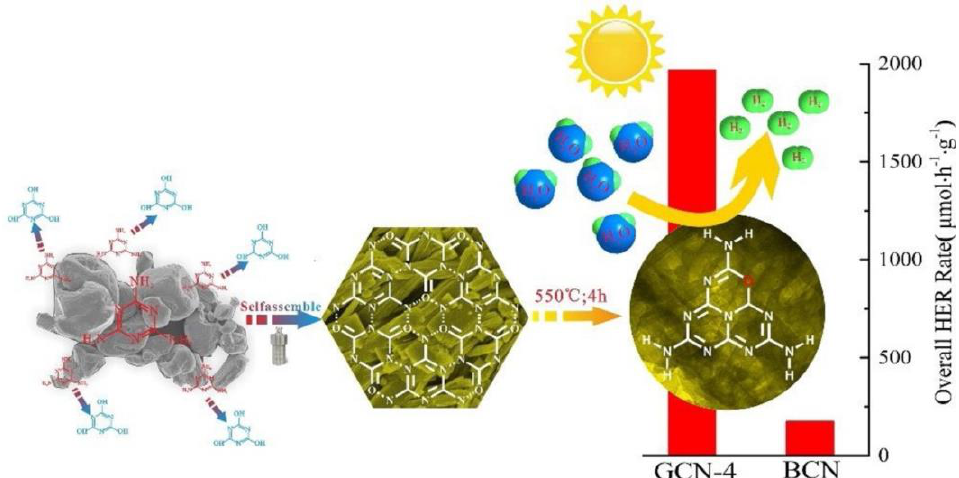
Figure 7. Illustration of the fabrication of porous O -doped g-C 3 N 4 from hydrogen bond-induced supramolecular precursor assembled under hydrothermal treatment. Reprinted with permission from Ref. [64] . Copyright 2018 Elsevier.